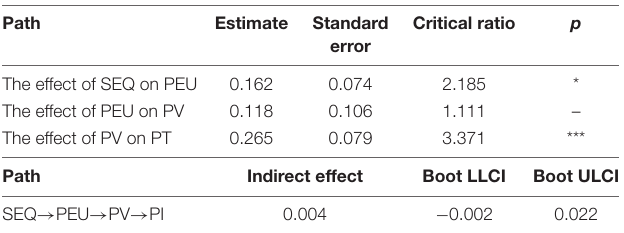
TABLE 6 | Results of path analysis 6.